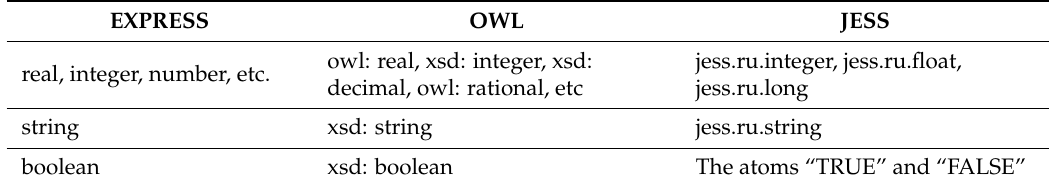
Table 3. The data type mapping relationships between EXPRESS, OWL, and JESS. EXPRESS OWL JESS owl: real, xsd: integer, xsd: real, integer, number, etc. decimal, owl: rational,